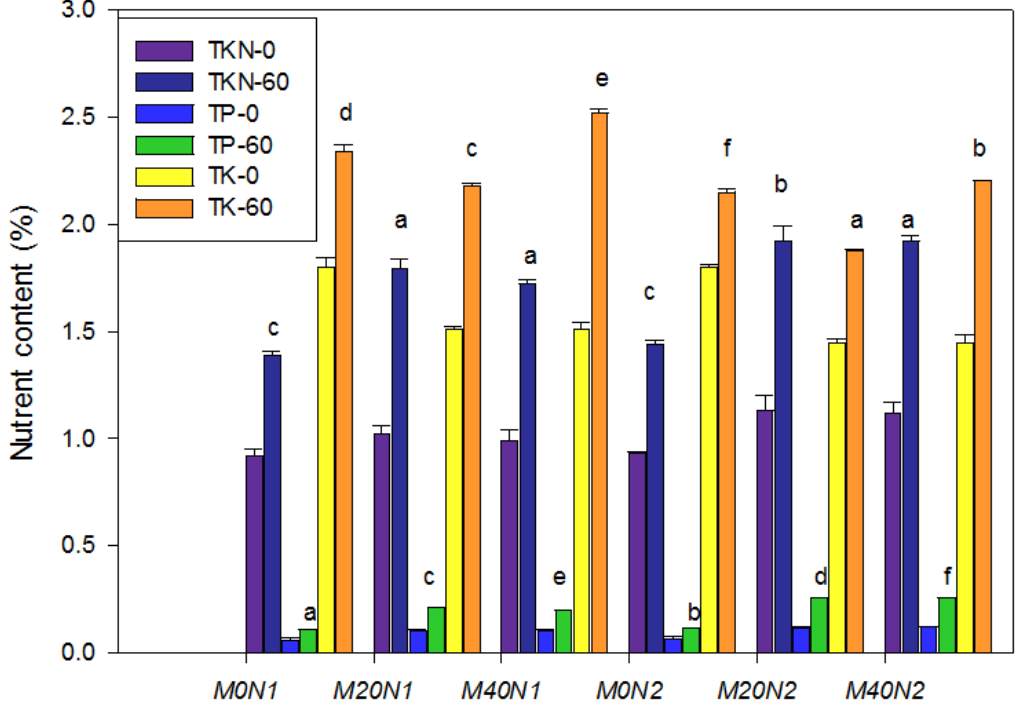
Figure 2. Total Kjeldahl nitrogen (TKN)%, total phosphorus (TP)%, and total potassium (TK)% in different treatments on days 0 and 60 of the experiment. (N-0:TKN% at 0 day; N-60:TKN% at 60 day; TP-0:TP% at 0 day; TP-60:TP% at 60 day; TK-0:TK% at 0 day; TK-60:TK% at 60 day). Compared the difference values of TKN-60 to TKN-0, TP-60 to TP-0, TK-60 to TK-0 in different treatments, the different letters of a, b, c, d were marked on the bar to indicate the significantly different which were determined by Tukey’s test ( p ˂ 0.05).